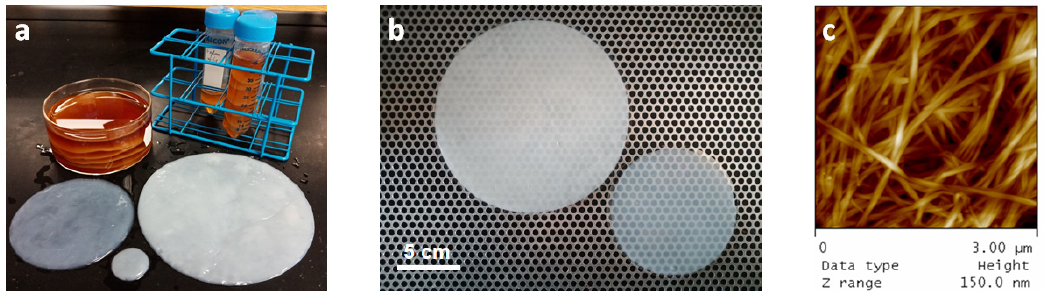
Figure 1. ( a ) Nanocellulose pellicles shown as grown in media and after cleaning. Multiple pellicles can be grown in one vat, and pellicles of various sizes can be grown. Pellicle sizes are 1 in, 4 in, and 6 in. ( b ) Nanocellulose pellicles dried into sheets on glass wafers, on the left is a 6 in sheet, and on the right is a 4 in a sheet. ( c ) AFM height measurements of a nanocellulose sheet.